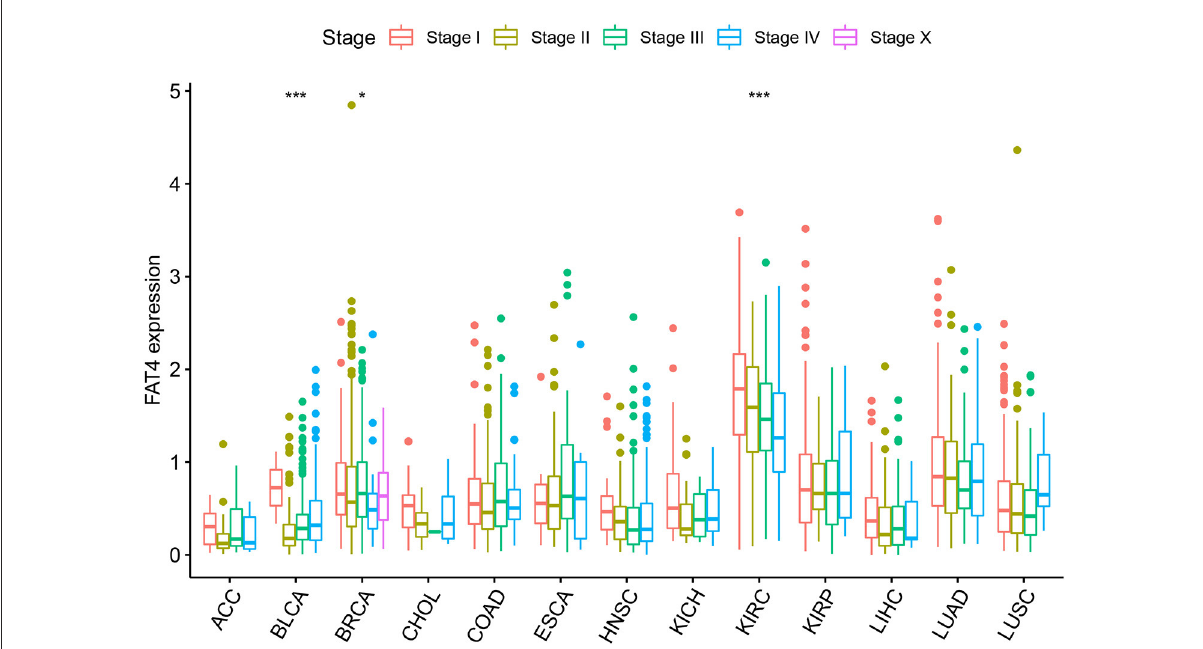
FIGURE2 Relationship between FAT4 and clinical stage. X-axis represents the tumor type, and Y-axis represents the expression level of FAT4. *Appears above the tumor, FAT4 expression levels is different in different stages of the tumor group in this tumor type; *represents P -value < 0.05; ***represents P -value <